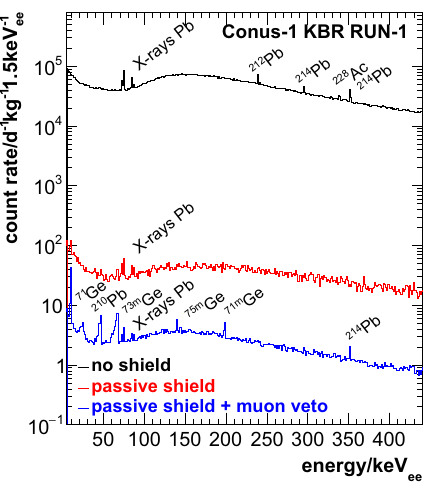
Fig. 2 Background suppression capability of the CONUS shield demonstrated for C1: Without any shielding, the black spectrum con- taining background lines of natural radioactivity is detected. The red spectrum is achieved by the passive shield alone. It is dominated by μ - induced background. The blue spectrum corresponds to the background withthe μ -vetoapplied,wherebackgroundlines,mostlyfromthedecay of metastable states from neutron capture in Ge, become